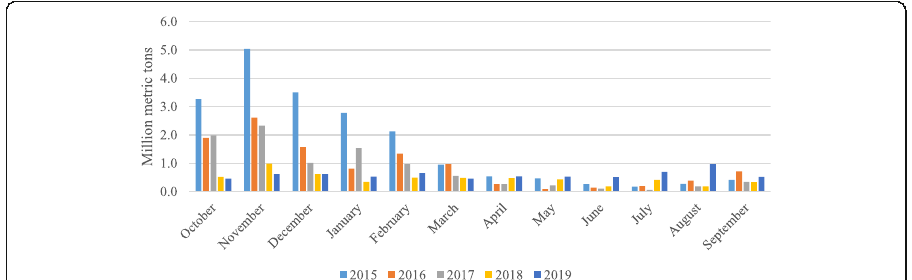
Fig. 4 Seasonality of Soybean Flows through the Panama Canal. Fiscal Year 2015 – 19. Source: Panama Canal internal